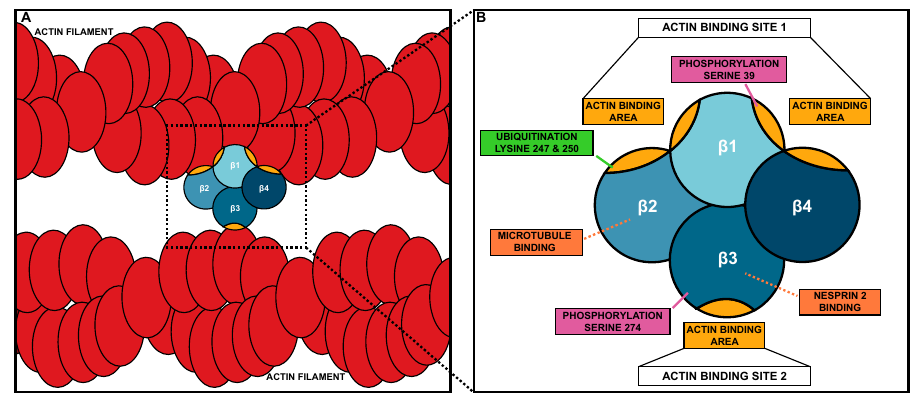
Figure 1. Fascin bundling mechanism and actin-binding domains. ( A ) Schematic of Fascin bundling two actin filaments (red). ( B ) Schematic of the domains and binding site of Fascin. The four β -trefoil domains of Fascin are in di ff erent shades of blue. Actin-binding areas of Fascin are in gold. In B, the di ff erent protein interaction sites and post-translational modifications are labeled.